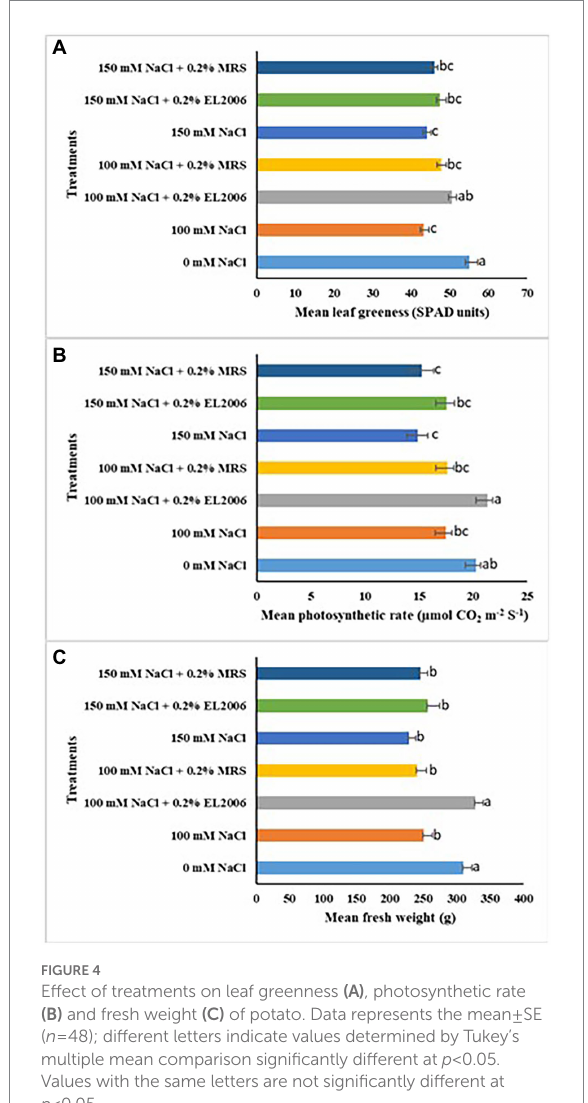
FIGURE 4 Effect of treatments on leaf greenness (A) , photosynthetic rate (B) and fresh weight (C) of potato. Data represents the mean ± SE ( n = 48); different letters indicate values determined by Tukey’s multiple mean comparison significantly different at p < 0.05. Values with the same letters are not significantly different at p <